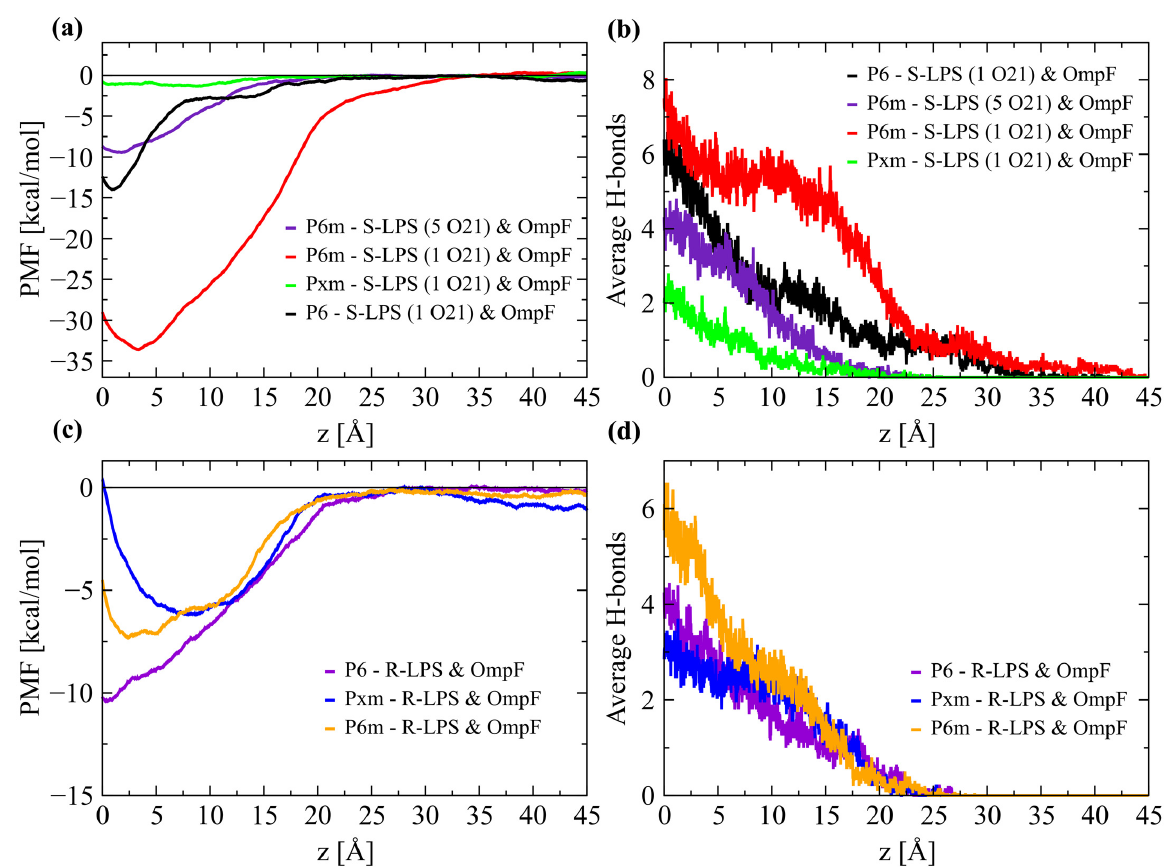
Figure 2. PMF binding energy of representative AMPs inserted in ( a ) S-LPS and ( c ) R-LPS E. Coli membrane models. Corresponding hydrogen bonds formed between the AMPs and LPS molecules/OmpF porin, averaged across all non-equilibrium MD simulations used for PMF calculation of ( b ) S-LPS and ( d ) R-LPS systems.